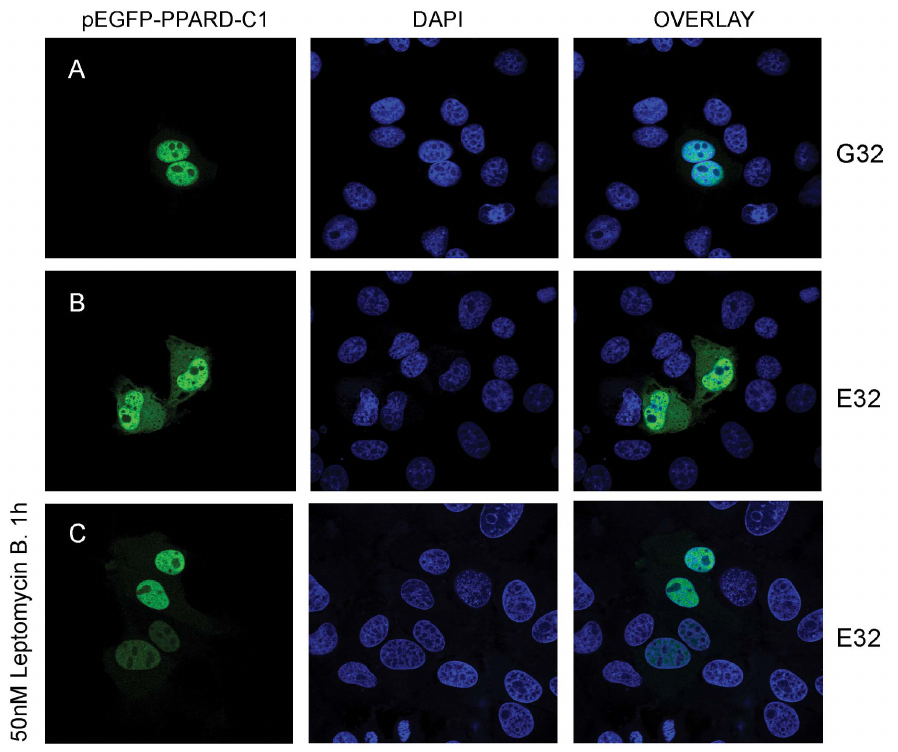
Figure 2. The G32E substitution stimulates CRM1-mediated nuclear export of sPPARD. PK-15 cells were transfected with pEGFP-C1-wild- type sPPARD (A), and -G32E mutant (B). G32E mutant was treated by leptomycin B (50 nM, 1 h) that blocked CRM1-dependent nuclear export (C). sPPARD subcellular localization was analyzed by GFP fluorescence at 24 hour post-transfection. Cell nuclei were counterstained with DAPI. doi:10.1371/journal.pone.0075925.g002 mutants by leptomycin B treatment that blocks CRM1-dependent shuttling [26]. The pEGFP-C1-sPPARD G32E mutant constructs were transiently transfected into PK-15 cells. After 24 hours, cells were treated 1 hour with 50 nM leptomycin B. The treatment blocked cytosolic localization of G32E mutants ( Figure 2C ).